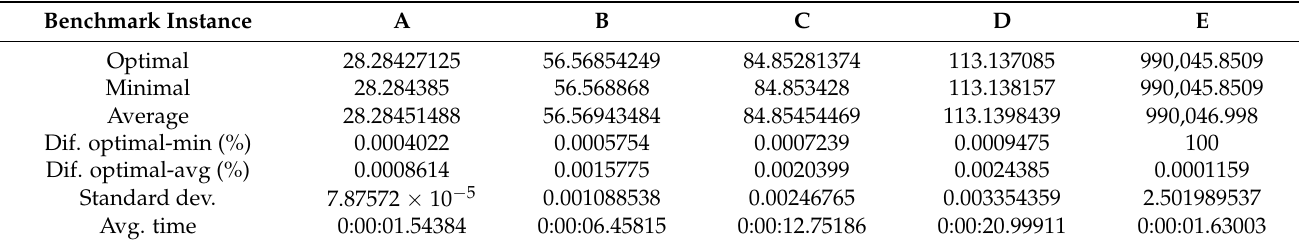
Table 7. Calculations MPC1.